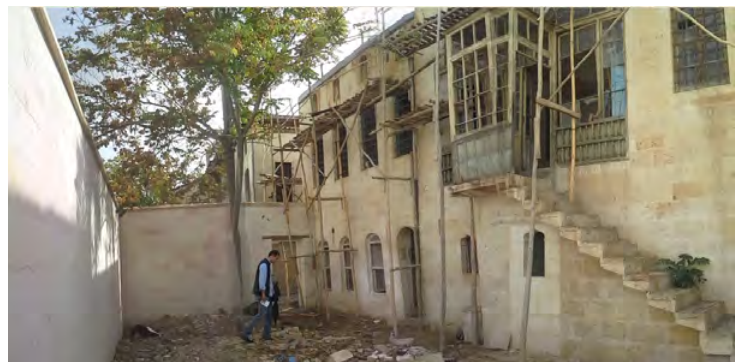
Figure 10. Courtyard and eyvan in traditional Gaziantephouse (Tas¸tan, 2014)